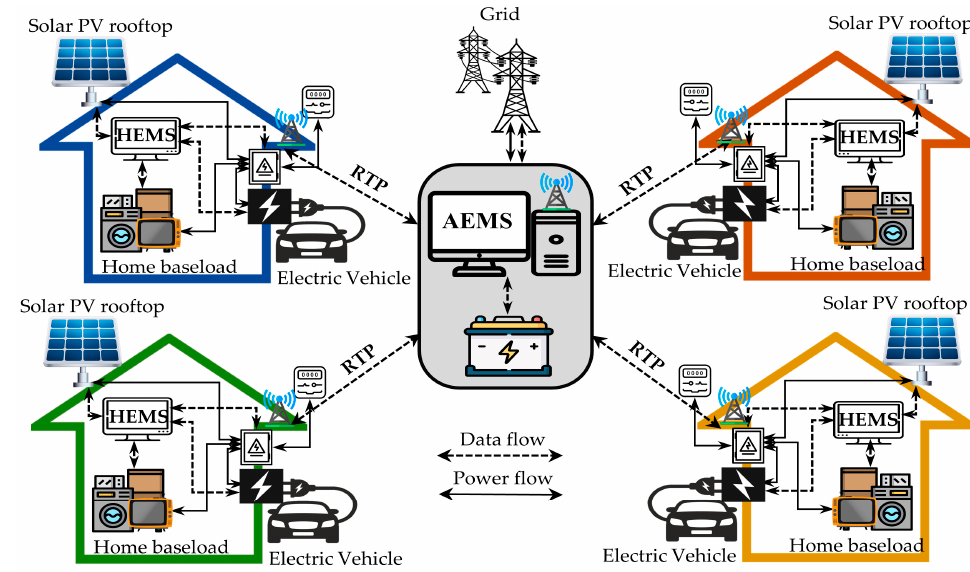
Figure 1. The proposed energy management framework.